Question: In a single sentence, describe what this figure presents.
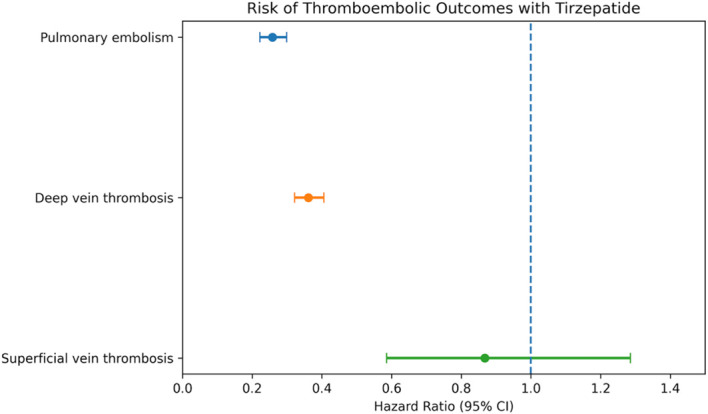
Answer: Baseline characteristics of propensity score-matched cohorts.